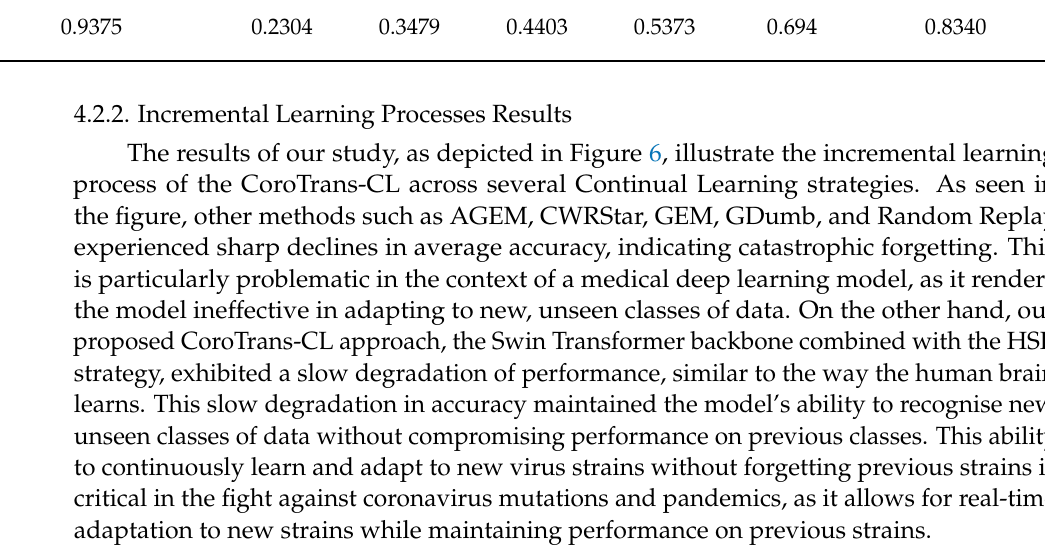
Table 4. A comparison of the average accuracy of different strategies.